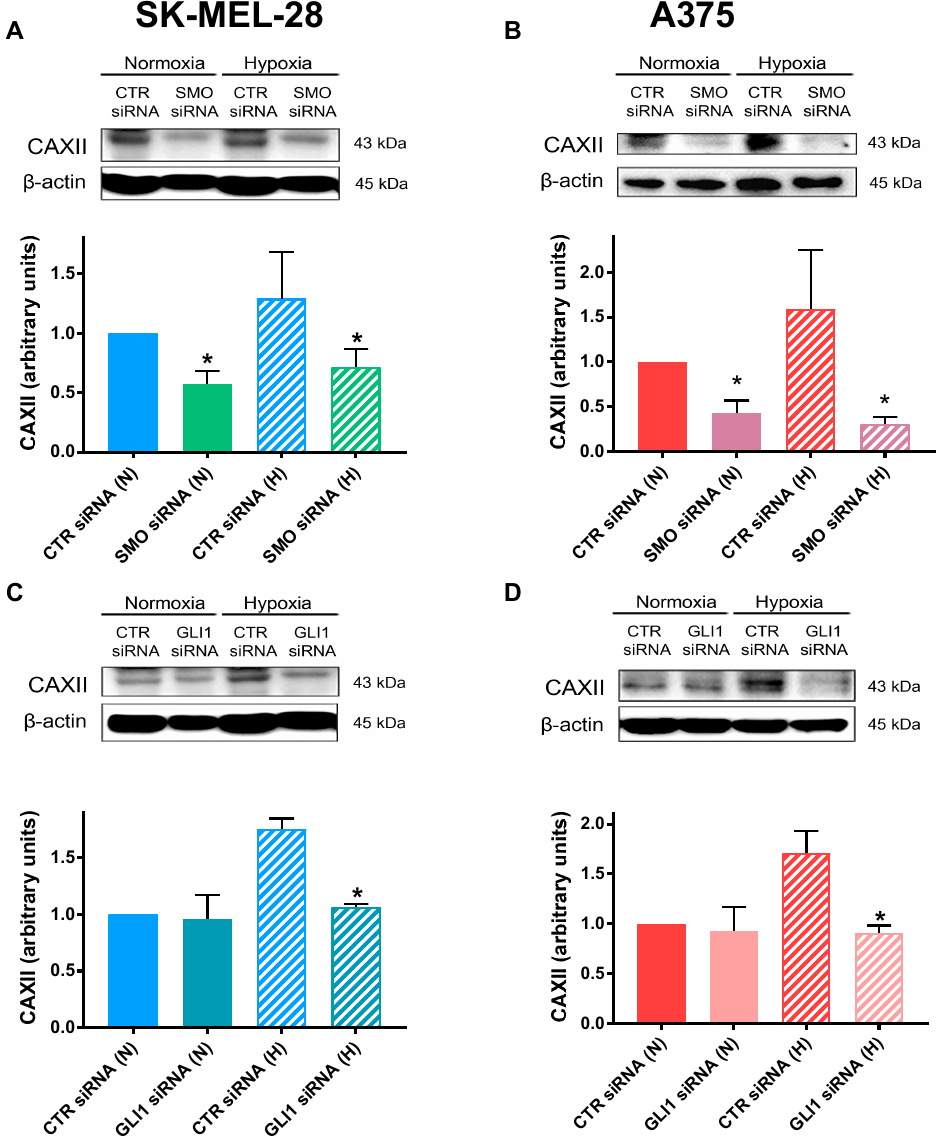
Figure 4. SMO and GLI1 transient knockdown reduced CAXII protein levels. CAXII protein expres- sions as determined by western blot analysis in SK-MEL-28 and A375 silenced with SMO siRNA ( A , B ) and GLI1 siRNA ( C , D ) under normoxic (N) or hypoxic (H) conditions. β -actin was used as loading control. Blots are representative of three independent experiments. Means ± SEM are presented. (n = 3; * p ≤ 0.05 indicates statistically significant difference).